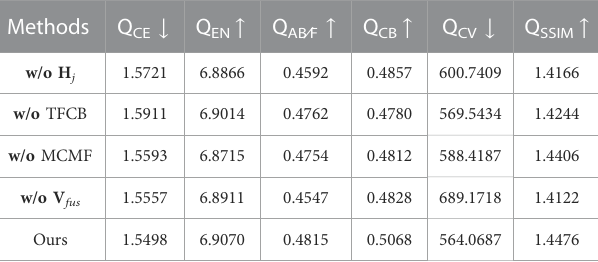
TABLE 3 Analysis of the effectiveness of different functional modules. TABLE 4 The effect of different nuber of TFCBs on fusion